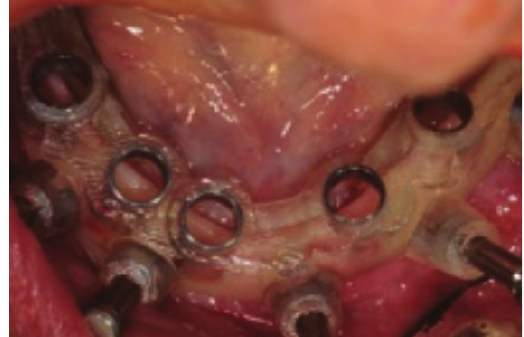
Figure 8: The two osteotomes very close.